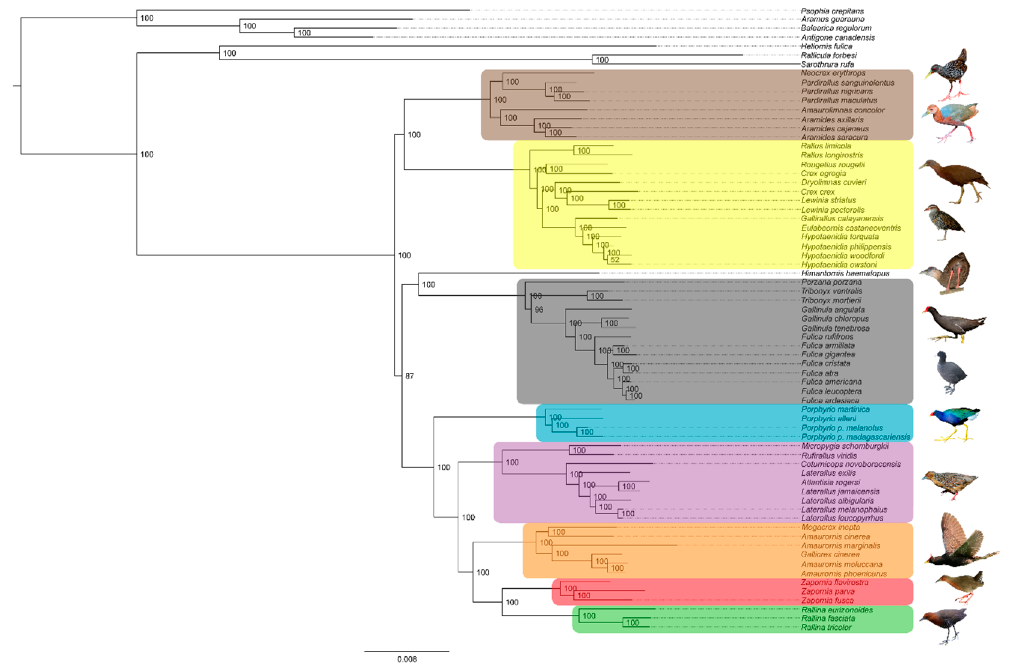
Figure 1. RAxML phylogeny of the rails and other Gruiformes based on a 393-gene matrix. Bootstrap support values are shown at nodes. Coloured boxes indicate clades as in Garcia-R et al. [12] where brown = “ Aramides” ; yellow = “ Rallus” ; black = “ Fulica” ; blue = Porphyrio ; purple = “ Laterallus” ; green = Rallina ; red = “ Porzana” ; and orange = “ Gallicrex” .